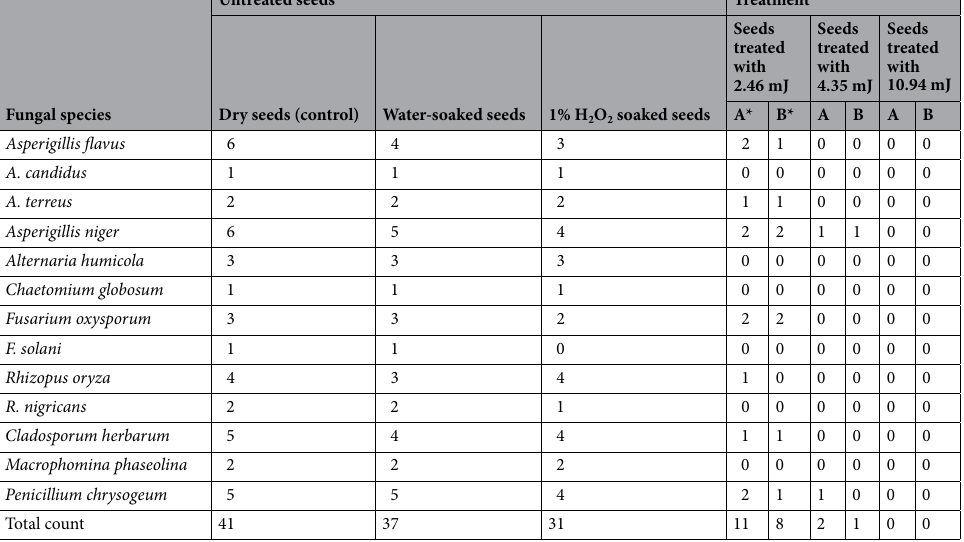
Dose of cold plasma